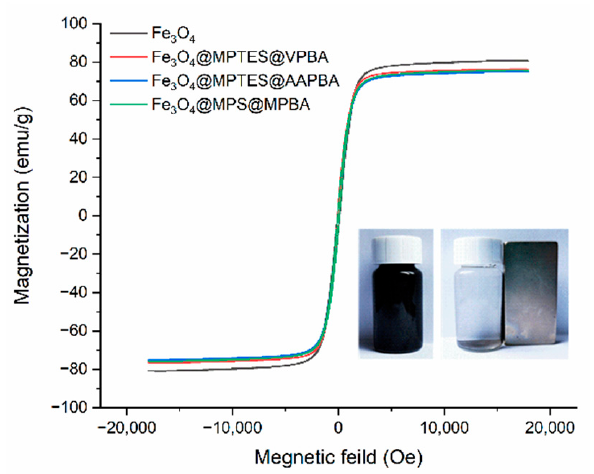
nanoparticles have no obvious hysteresis loop and coercivity. In addition, nanoparticles dispersed in water can be reaggregated within 15 s under an applied magnetic field. The above analysis results and experimental phenomena shown that the prepared Fe 3 O 4 @PBA nanoparticles have excellent superparamagnetism.